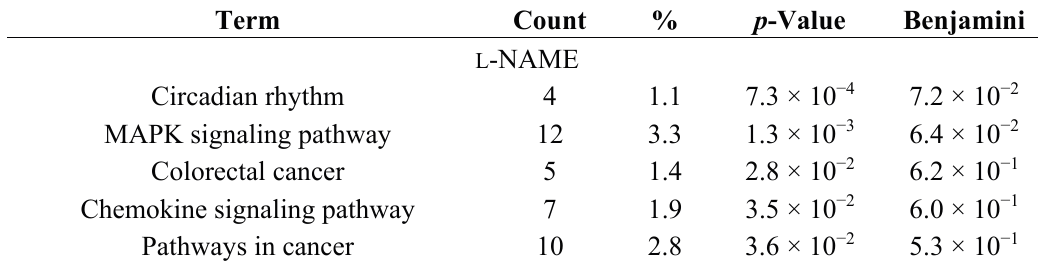
Table 2. Significantly regulated KEGG pathways in the kidney of L -NAME-treated offspring and L -NAME + CIT-treated offspring vs. control at three months of